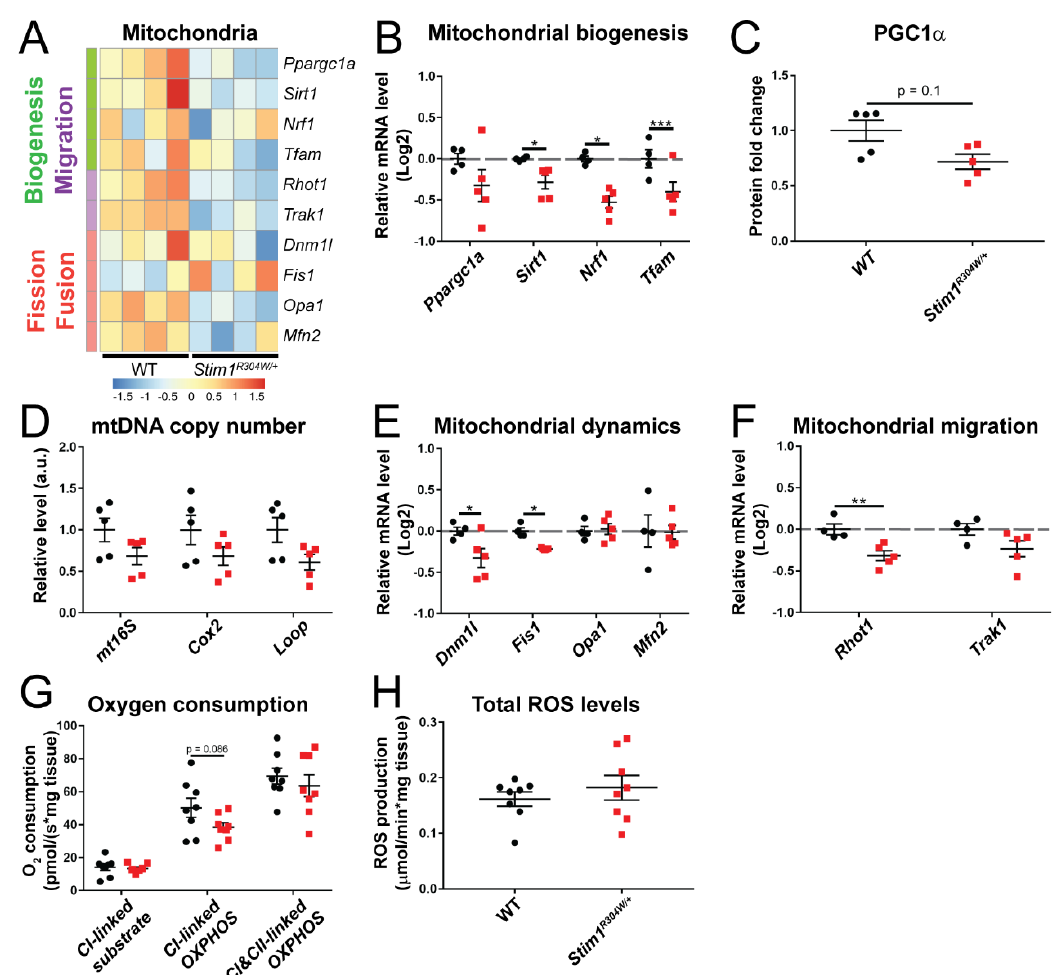
Figure 3. Minor mitochondrial defects in Stim1 R304W/+ muscle. ( A ) RNAseq heatmap showing the rel- ative gene expression of genes involved in mitochondrial biogenesis, migration, fission, and fusion in Stim1 R304W/+ and WT tibialis anterior ( n = 4). ( B , C ) RT-qPCR confirmed the reduction of the mito- ( n = 4). ( B , C ) RT-qPCR confirmed the reduction of the mitochondrial biogenesis genes Sirt1 , Nrf1 , and Tfam in Stim1 R304W/+ chondrial biogenesis genes Sirt1 , Nrf1 , and Tfam in Stim1 R304W/+ mice, and indicates a decreased mice, and indicates a decreased PGC1 α ( Ppargc1a ) gene expression and protein level ( n = 4–5). ( D ) The quantities of the mitochondrial copy number maker genes mt16S , Cox2 , and Loop tend to be reduced in Stim1 R304W/+ tibialis anterior ( n = 5). ( E , F ) Mitochondrial fission ( Dnm1l and Fis1 ) and migration ( Rhot1 ) genes are downregulated in Stim1 R304W/+ mice ( n = 4–5). ( G , H ) Analysis of oxygen consumption shows a comparable mitochondrial non-phosphorylating respiration (CI-linked substrate), oxidative phosphorylation (CI-linked OXPHOS and CI/CII-linked OXPHOS), and ROS production in Stim1 R304W/+ and WT tibialis anterior ( n = 8). Significant differences are illustrated as * ( p < 0.05), ** ( p < 0.01), and *** ( p <